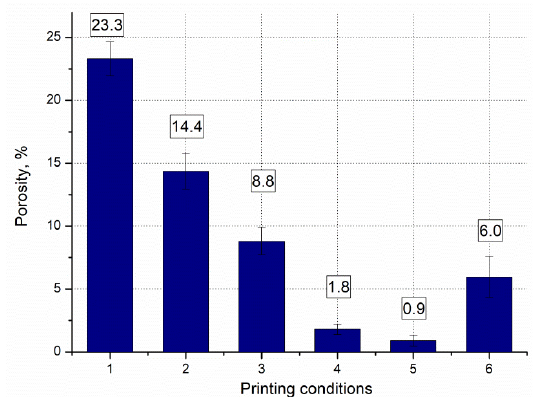
Figure 5. Bar chart showing the influence of the printing parameters (given in Table 2) on the porosity of the M789 steel.